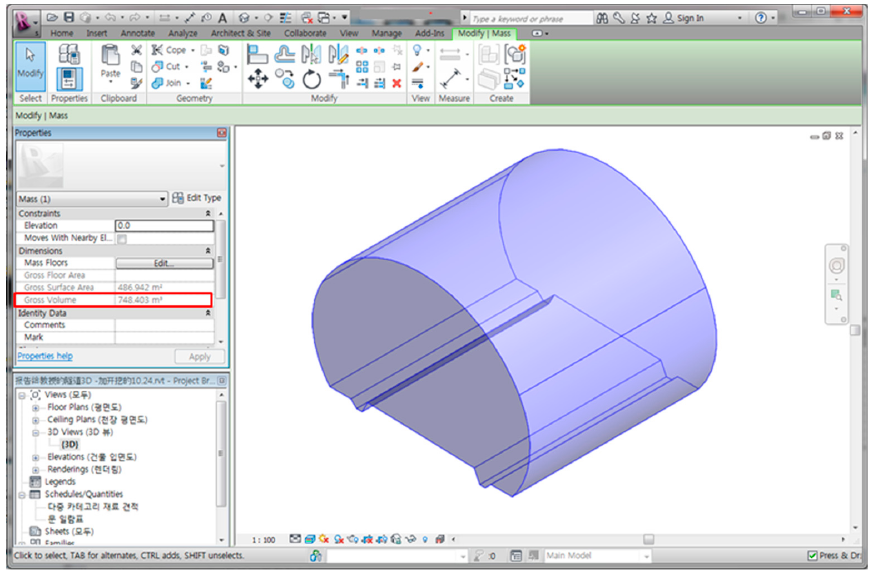
Figure 8. Tunnel excavation scope.